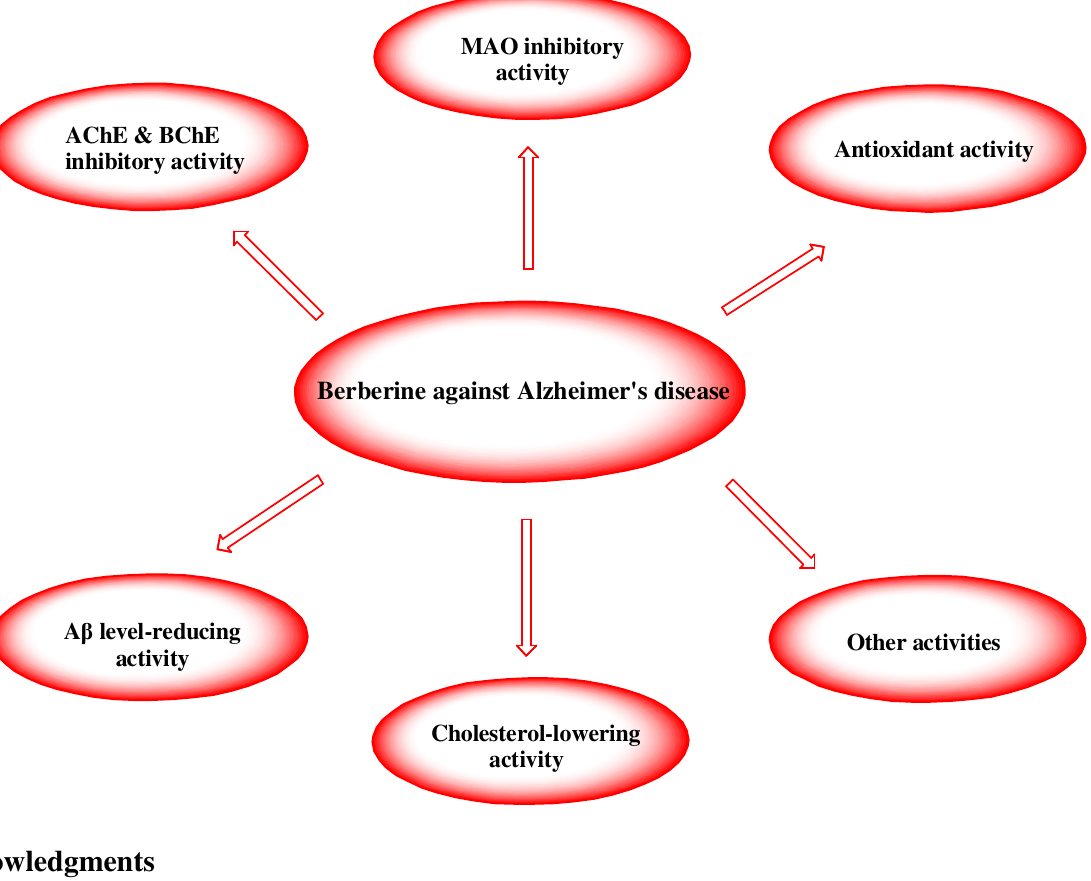
Figure 2. Potential mechanisms rendering berberine a multiotent agent to combat